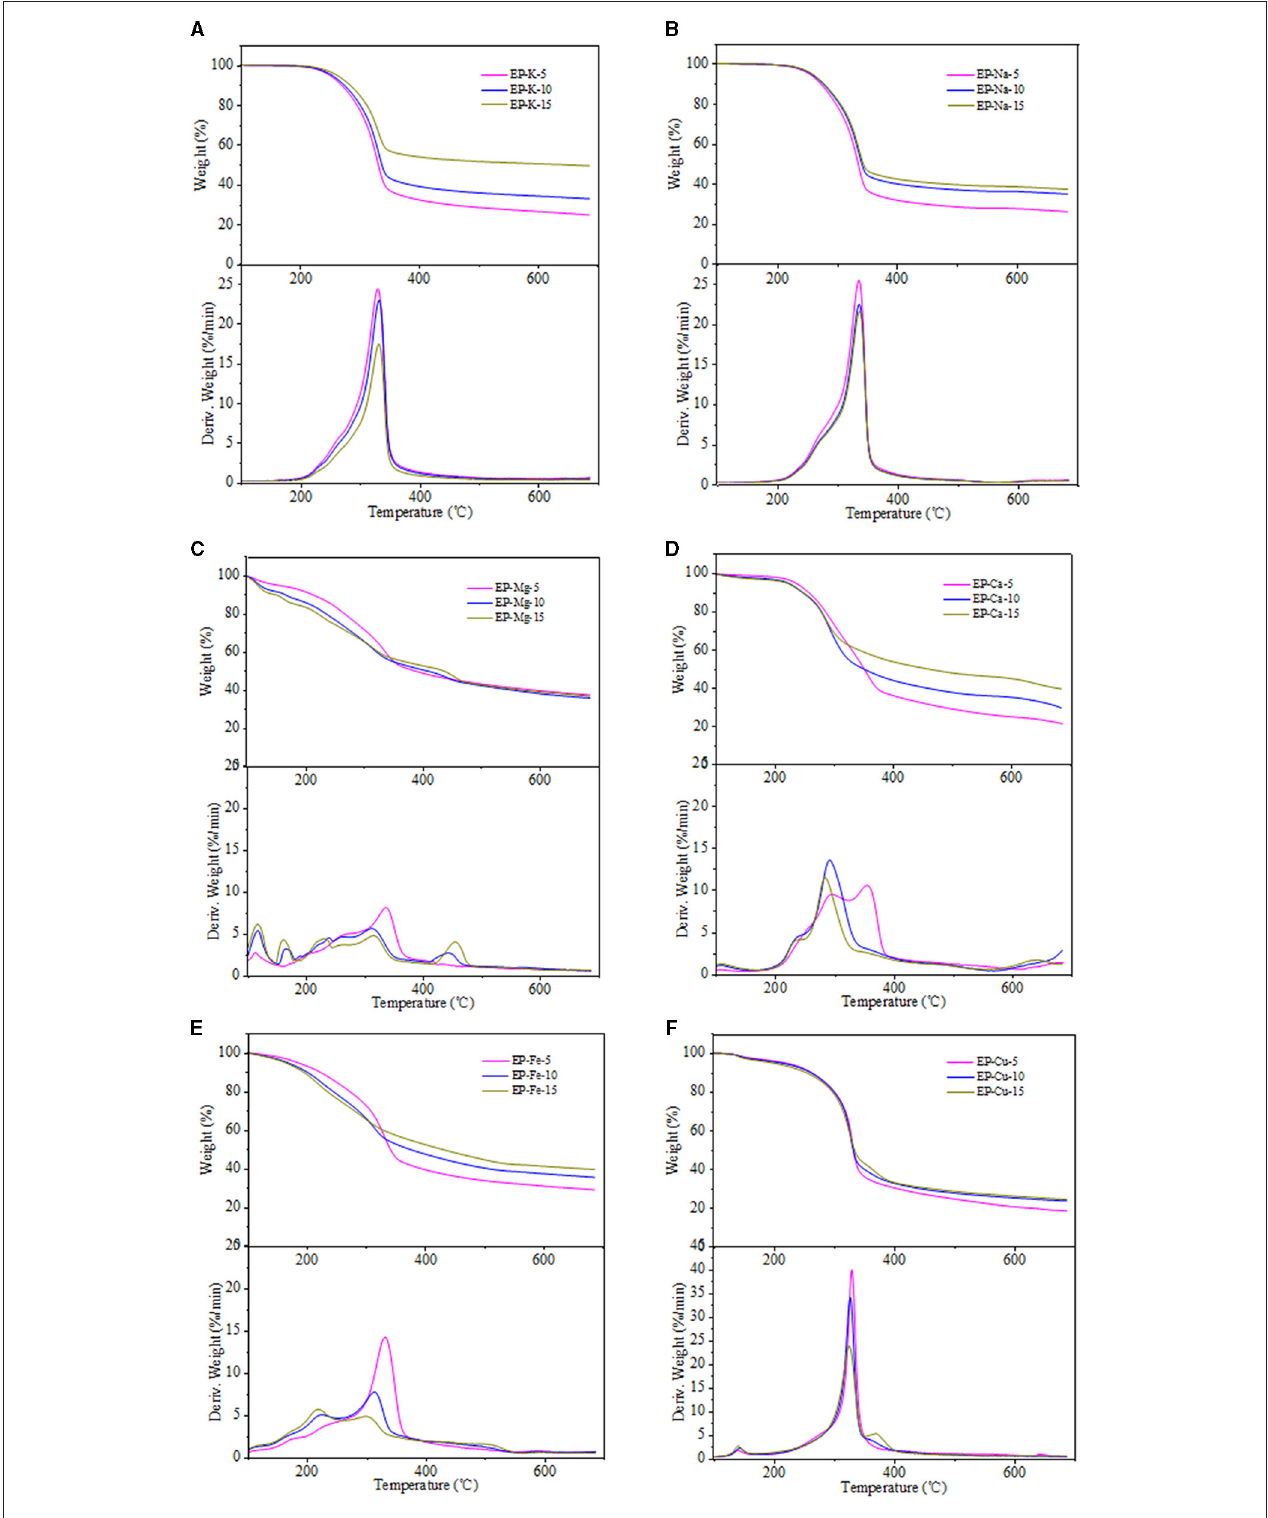
FIGURE 3 | (A–F) TG and DTG curves of metal loaded eucalyptus samples.